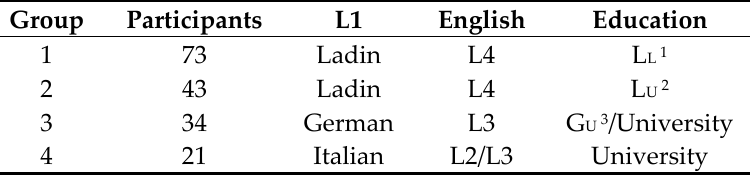
Table 1. Participants who provided the frog-story narratives.